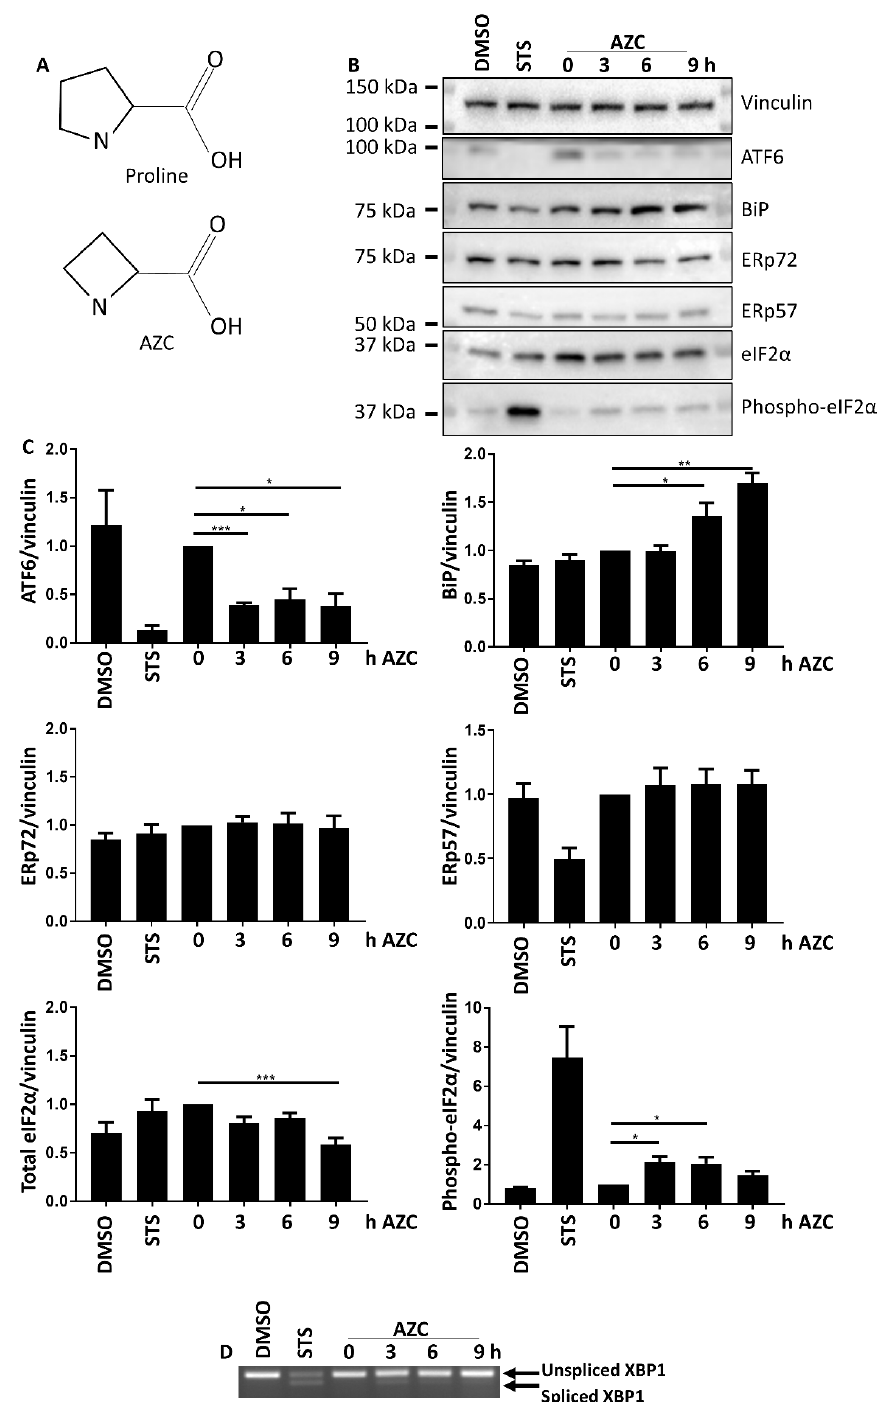
Figure 1. ( A ) L -azetidine-2-carboxylic acid (AZC) is an analog of proline. ( B ) AZC induces cleavage of ATF6 and upregulates BiP expression and phospho-eIF2 α levels, but does not affect ERp57 or ERp72 expression. Cells were treated for 6 h with DMSO or 1 µ M staurosporine (STS) as control, or for 0–9 h with 5 mM AZC, and during the last 4 h 100 nM Baf A1 was added. A representative blot for six independent experiments each performed in duplicate showing protein levels of ER stress markers ATF6, BiP, ERp72, ERp57, total eIF2 α , and phospho-eIF2 α . Vinculin was used as loading control. ( C ) Quantification of ER stress markers in B shown as mean ± SEM relative to 0 h AZC. * p < 0.05, ** p < 0.01, *** p < 0.001. ( D ) Representative RT-PCR gel of unspliced and spliced XBP1 mRNA levels of three independent experiments each performed in